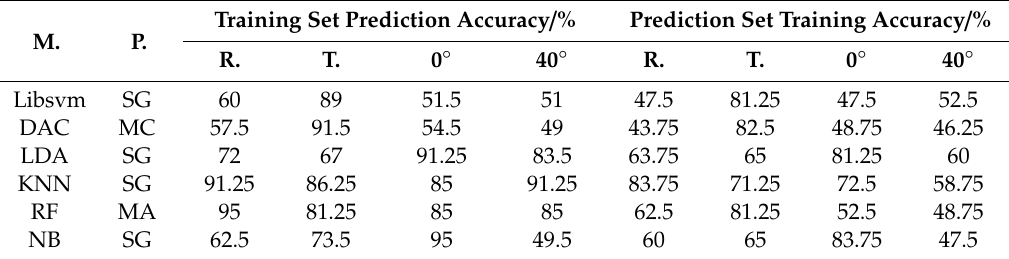
Table 3. The accuracy of the modeling based on PCA (the table shows the highest accuracy).